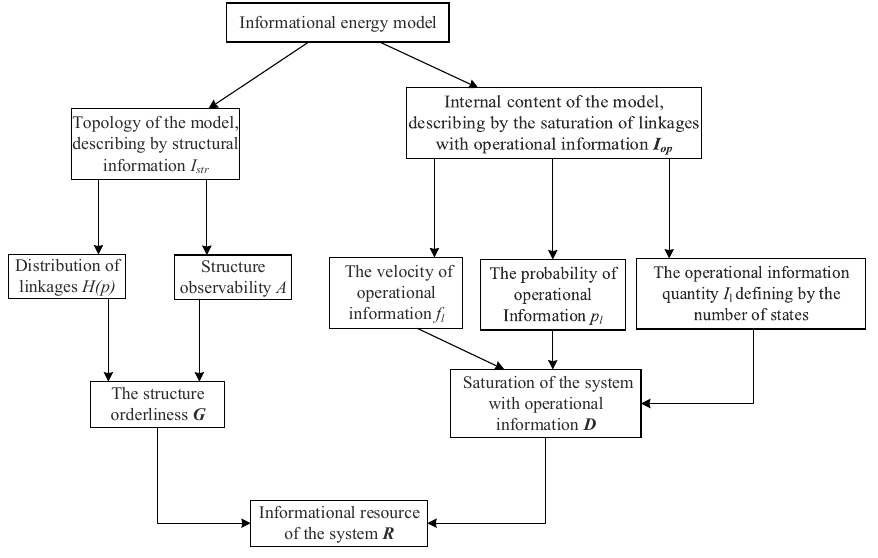
Figure 1. The generalized structure of the IEM.